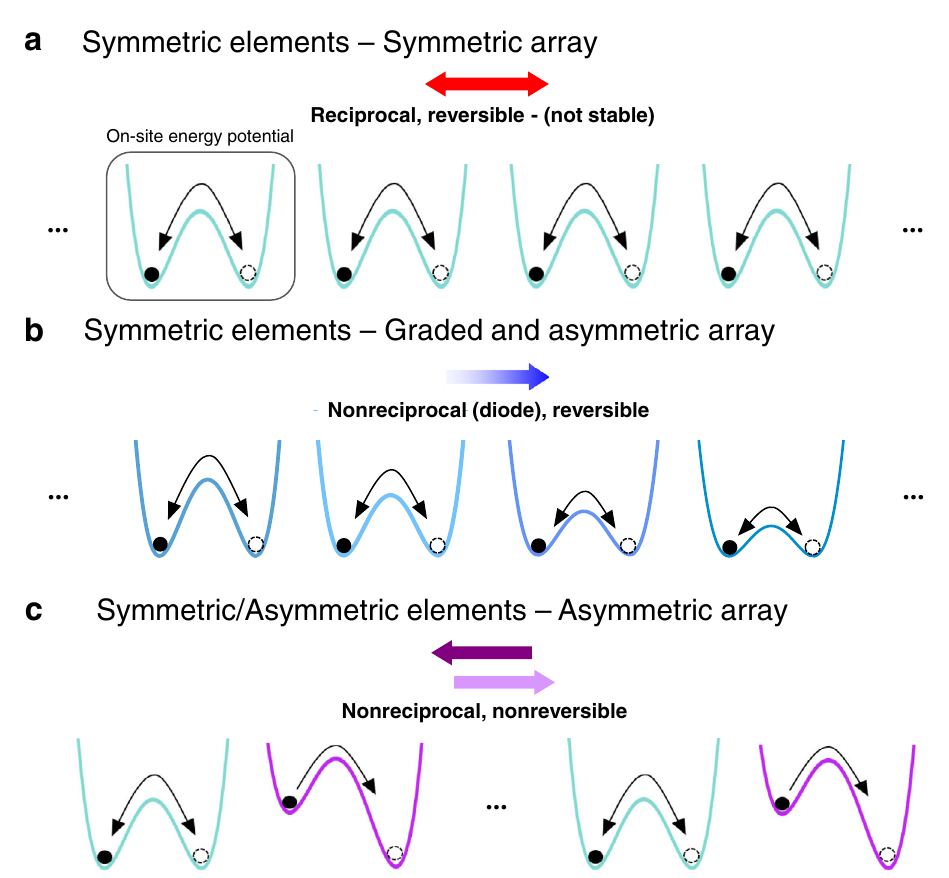
Fig. 1 Programming nonreciprocity and reversibility. a Signal propagation in a chain comprising identical bistable elements with symmetric energy wells is reciprocal and reversible, but not stable. b Signal propagation in a chain comprising bistable elements with symmetric energy wells, but decreasing energy barriers is nonreciprocal and reversible. c Signal propagation in a chain comprising bistable elements with both symmetric and asymmetric energy wells is nonreciprocal and